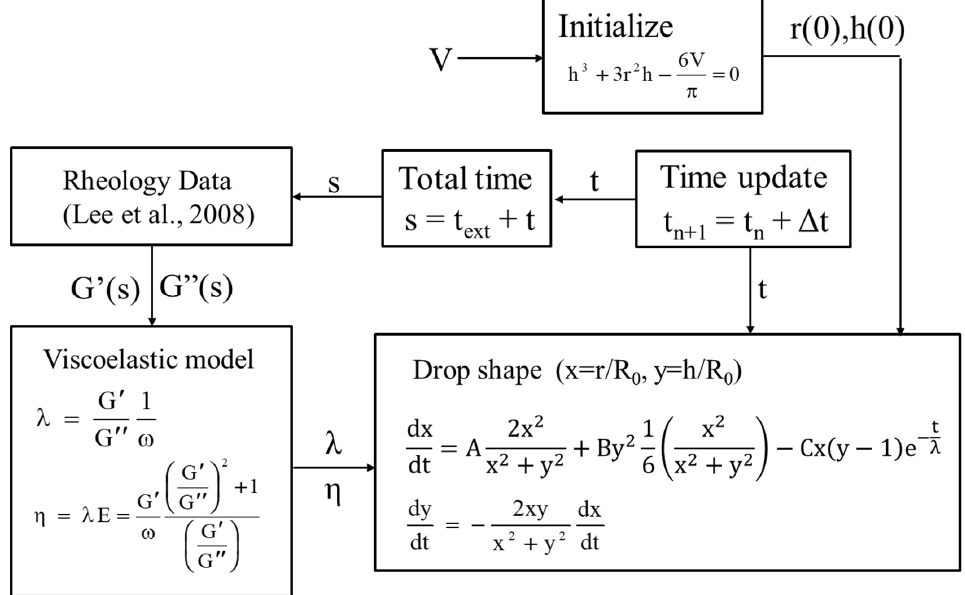
Figure 4. Film spreading algorithm for linear viscoelastic fluids with variable properties.